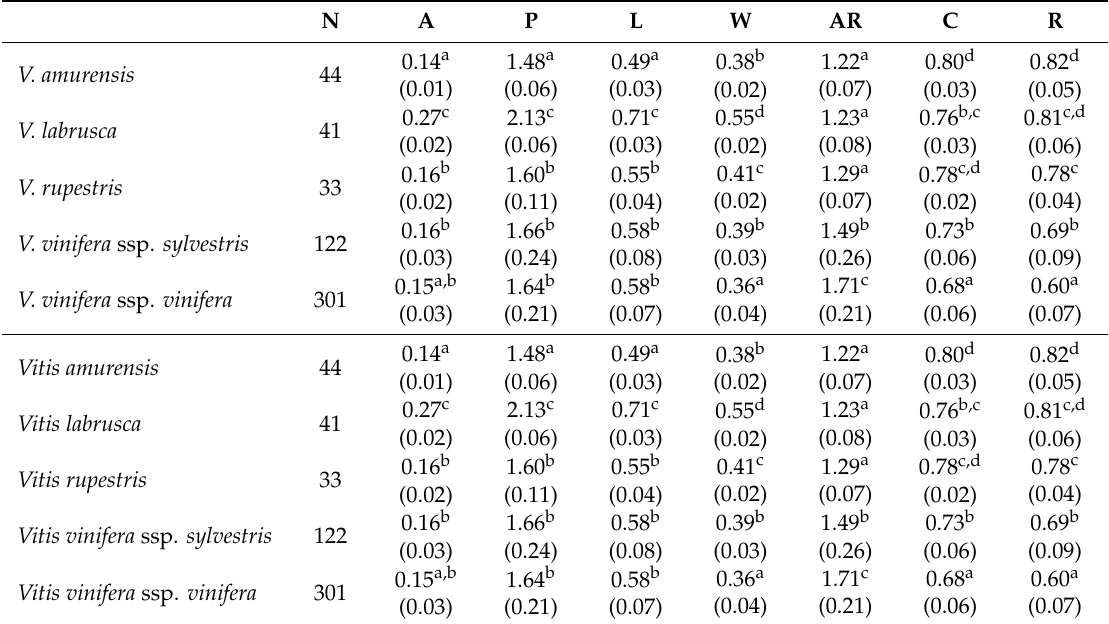
Table 1. Mean values of the area (A), perimeter (P), length of the major axis (L), length of the minor axis (W), aspect ratio (AR is the ratio L / W), circularity (C) and roundness (R) in the seeds of four species of Vitis analyzed. N A P L W AR